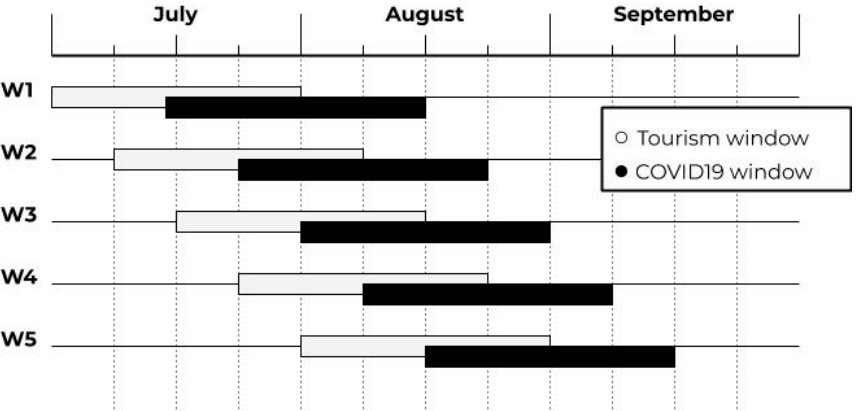
Figure 3. The tourism/COVID-19 dataset, structured based on sliding windows. White are the windows used for the tourist data, black are the windows used for the cumulative count of new infected cases. The black windows are shifted 14 days forward to account for the time required for the COVID-19 symptoms to manifest.